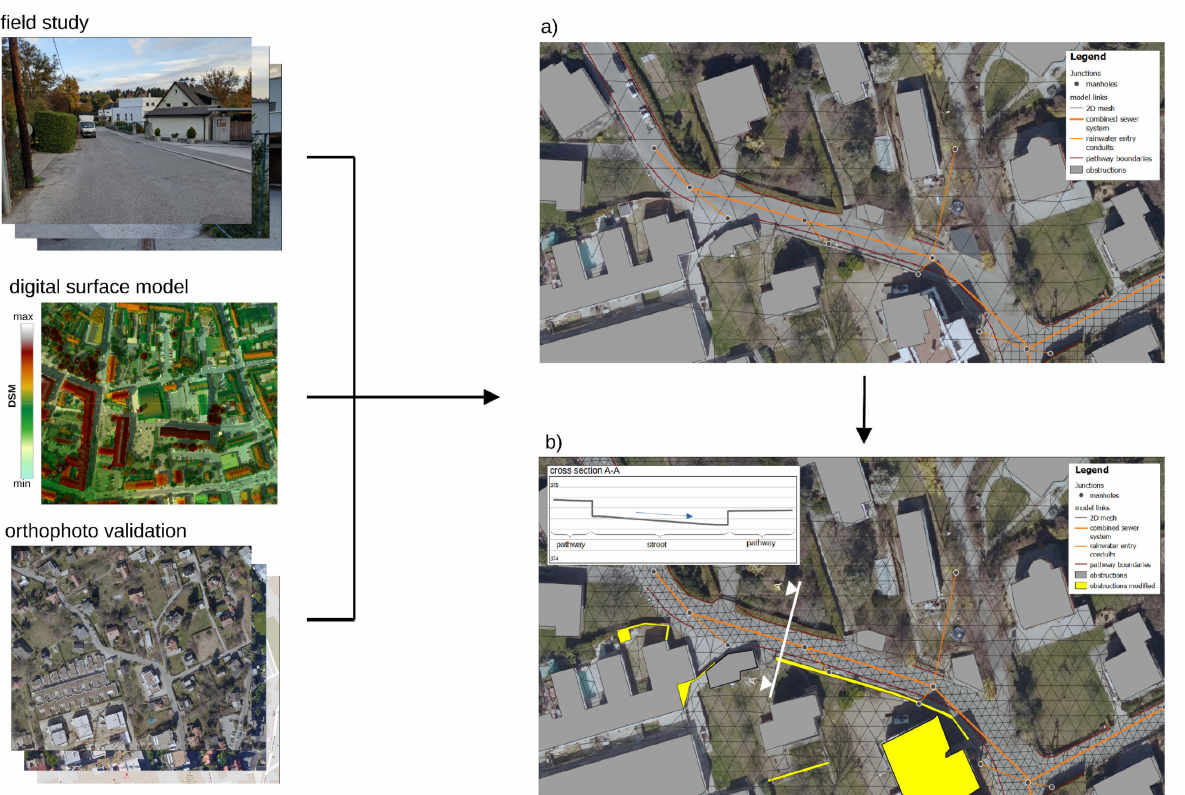
Figure 5. Modification of the DEMraw ( a ) and the revised 2D mesh ( b ) as a result of a field study with photo documentation, identification of missing obstructions with the digital surface model and validation of the spatial structure with open online-mapping tools such as Google Maps, Google Earth, or OpenStreetMap.